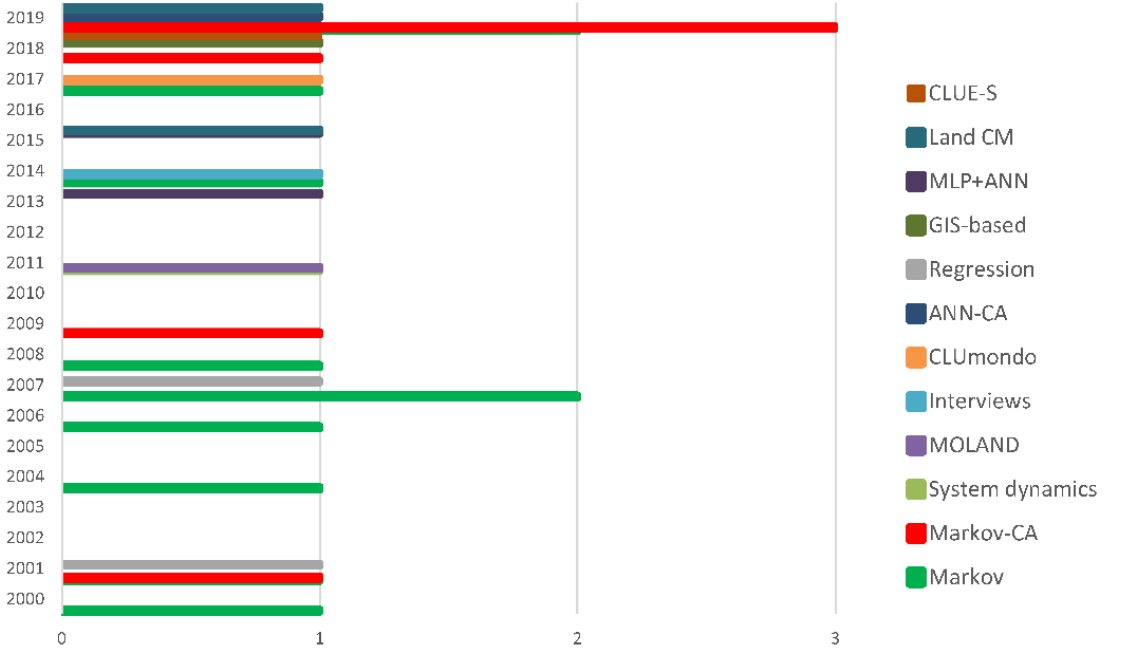
Figure 13. Number of manuscripts (29 in total) including models of future scenarios, by year. CLUE-S: conversion of land use and its effects at small regional extent; Land CM: Land Change Modeler; MLP + ANN: multi-layer perceptron neural network; ANN-CA: artificial neural network-based cellular automata; CA: cellular automata.